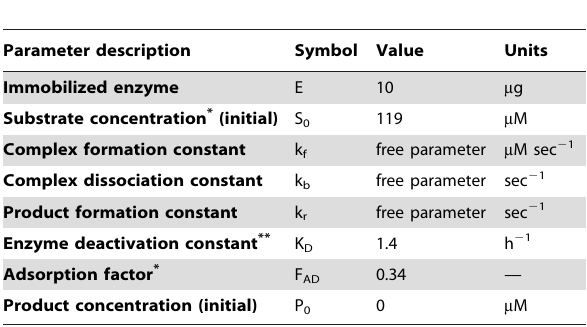
Table 1. Parameters used in the analytical solution of the ODE system.